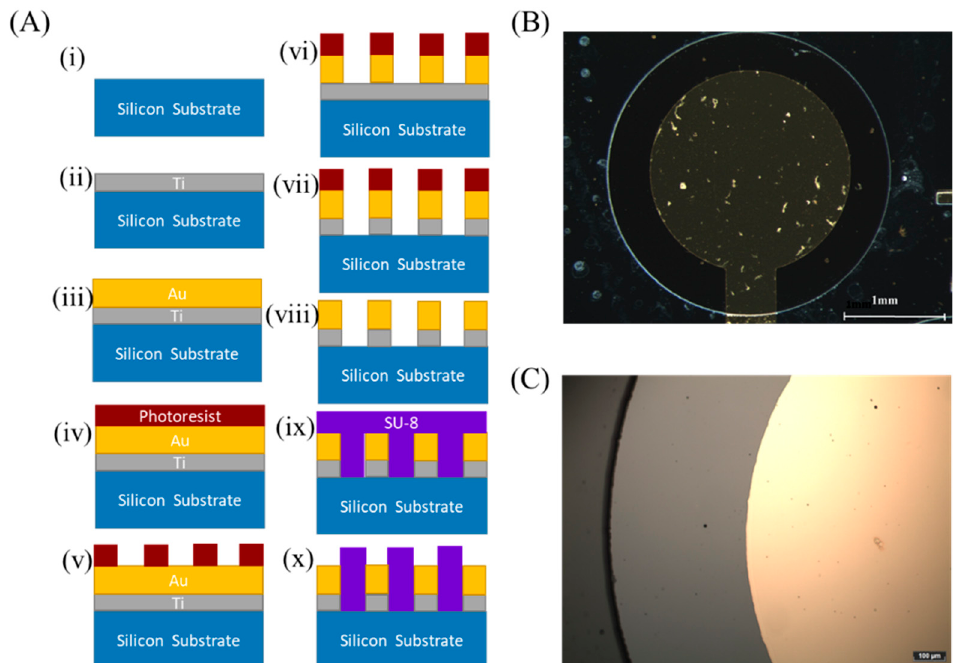
Figure 2. Microfabrication of the gold electrodes. ( A ) A microfabrication flow process: ( i ) Si/SiO 2 substrate was cleaned, ( ii ) Ti was deposited onto the Si/SiO 2 wafer, ( iii ) Au was deposited onto the Si/SiO 2 /Ti, ( iv ) a TiX-Lift photoresist was spin-coated onto the wafer, ( v ) the photoresist was patterned with UV and developed, ( vi ) Au was etched from the exposed areas, ( vii ) Ti was etched from the exposed areas, ( viii ) a photoresist was removed from the wafer, ( ix ) a SU-8 photoresist was spin-coated on the wafer patterned with electrodes, and ( x ) the photoresist was patterned with UV and developed to pattern the chambers. ( B ) An optical image of the whole microfabricated electrochemical chamber patterned with SU-8. ( C ) A zoomed-in image of the microfabricated electrode with the SU-8 chamber.